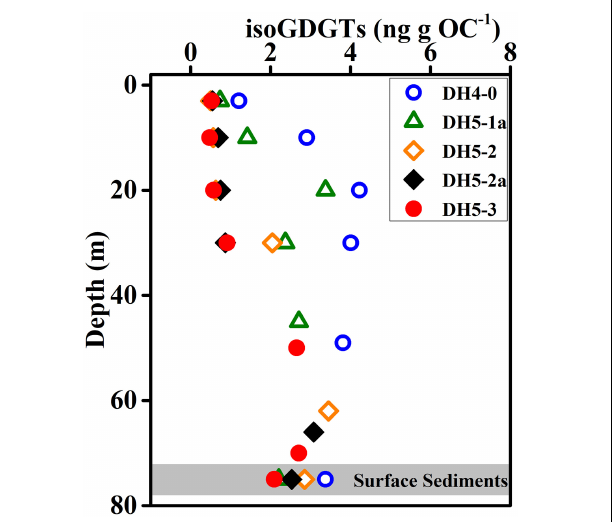
FIGURE 7 | Vertical distributions of isoGDGTs in the water column and surface sediments. Note the isoGDGT contents are normalized to organic carbon